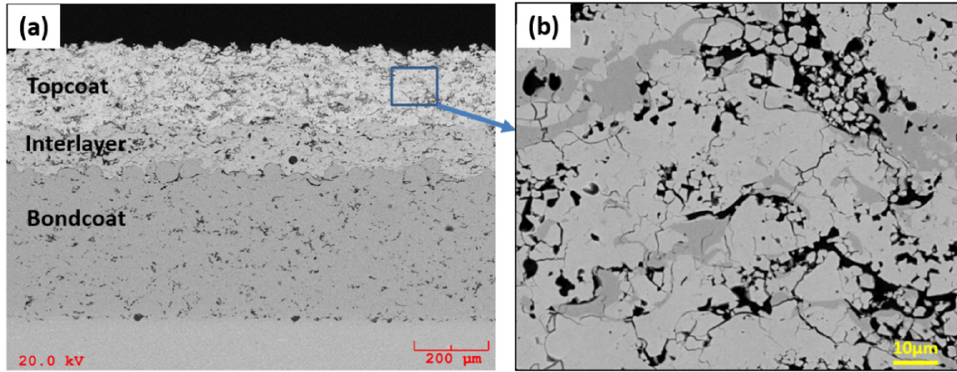
Figure 3. SEM images of the cross-section microstructures of the two-phase composite TBC: ( a ) as- sprayed TBC; ( b ) as-sprayed topcoat. Table 1. List of the TBC specimens used for testing, evaluation, and analyses.